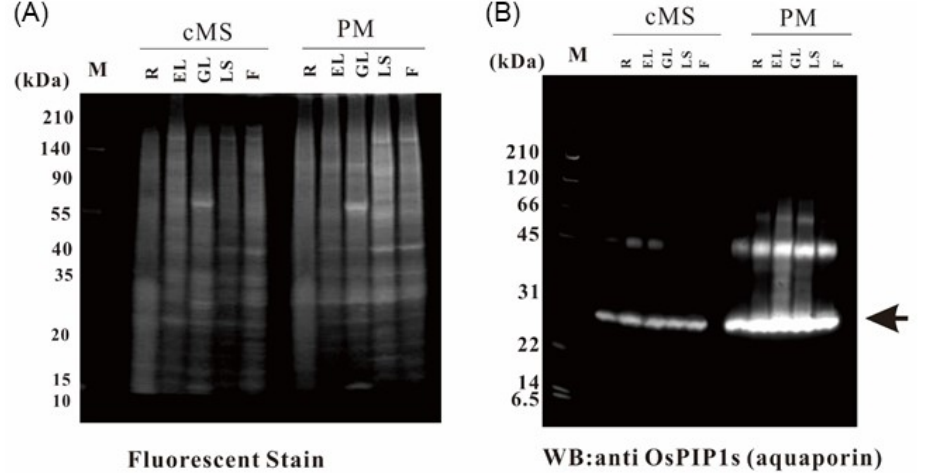
Figure 2. Purification of the plasma membrane fractions. The plasma membrane fractions were purified from the root (R), etiolated leaf (EL), green leaf (GL), leaf sheath (LS), and flower (F) using an aqueous two-polymer phase system. Five micrograms of proteins from crude microsomal fraction and the plasma membrane fractions were separated by SDS-PAGE. ( A ) Oriole fluorescent gel stain. ( B ) Immunoblot with an anti-OsPIP1s antibody targeting the plasma membrane marker aquaporin .